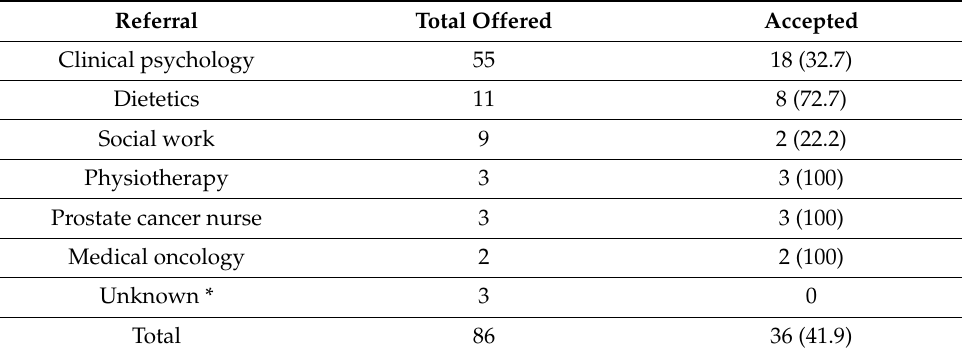
Table 2. Acceptance rates of referrals made following review of clinical